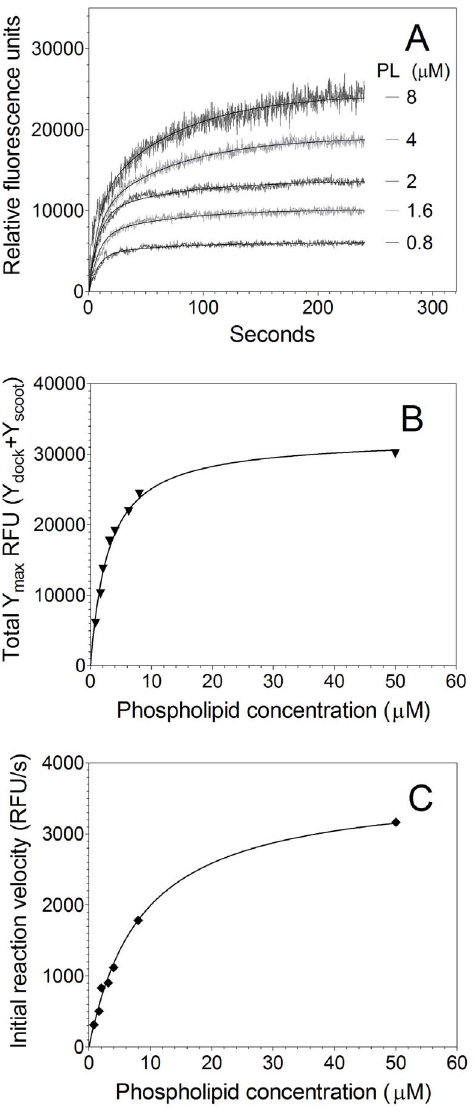
Figure 2. Relationship between PLA 2 concentration, phospho- lipid concentration, and phospholipase activity. ( A ) Varying concentrations of sonicated vesicles of composition PS:PE:PC:bbPC 4:20:75:1 were allowed to equilibrate at 4 u C for 5 minutes before adding 0.125 U/ml nmPLA 2 . The resulting curve replicates were standardized and fitted to a two-phase exponential association model (Eq. 1) and solved for global rate constants (fitted curves). ( B ) Total Y max obtained from fitted curves was plotted against phospholipid concentrations and fitted to a Michaelis-Menten equation. ( C ) The initial reaction rate was obtained from the original datasets using linear regression from 0–5 seconds and plotted against phospholipid concentration. A Michaelis- Menten equation was fitted to the data and of high fit quality. The results indicate a saturable dose-response relationship. Experiments at each phospholipid or phospholipase concentration were performed a minimum of two times, and values averaged.